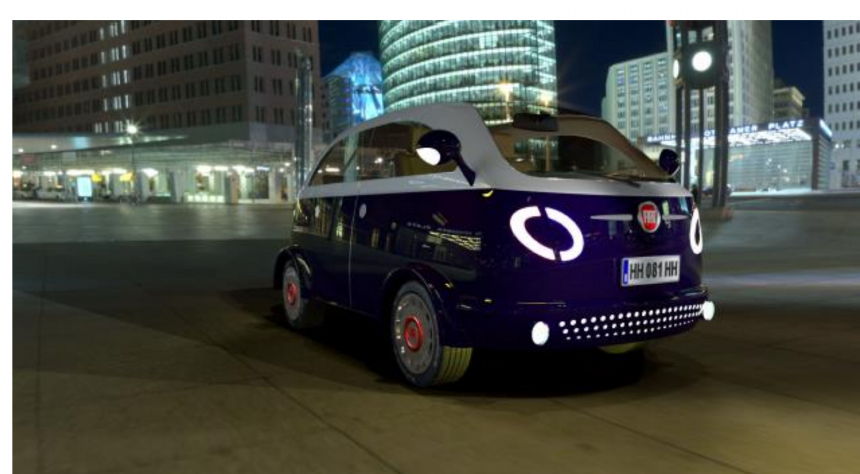
Figure 35. New FIAT 600 Omega—Rendering: City